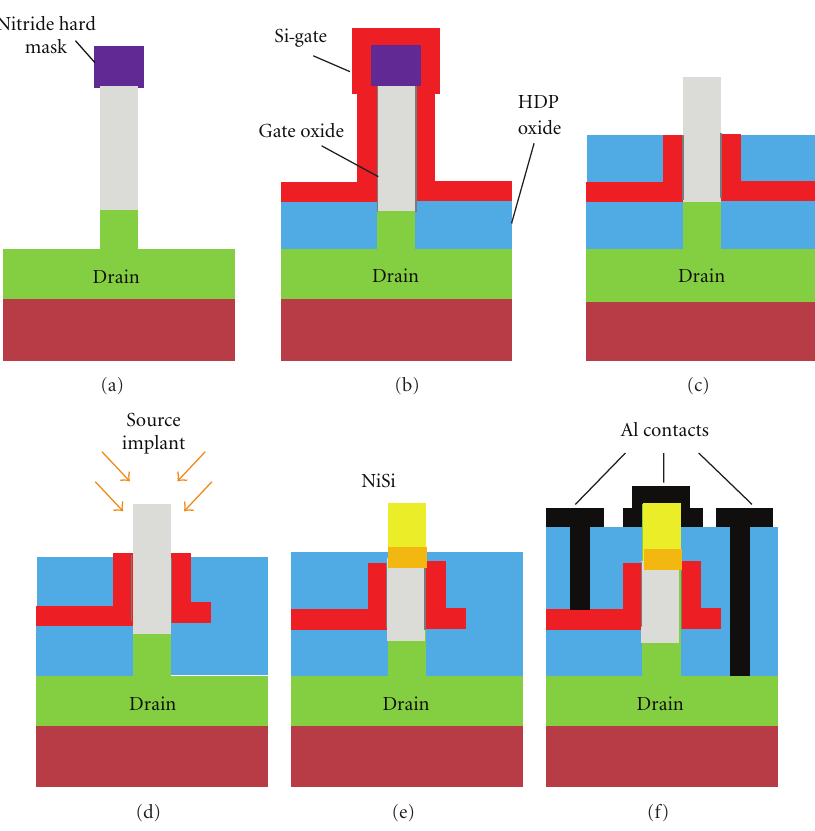
Figure 7: Vertical Silicon nanowire TFET process flow schematic. (a) Vertical pillar etch and As implantation to form the drain region, (b) isolation oxide deposition and gate stack formation, (c) the top amorphous-Si etched to expose source side of TFET, (d) source implanted with BF 2 , (e) dopant segregated Ni silicidation, (f) contact opening and Al metallization. (Reprinted with permission from [29] [2011] IEEE.)